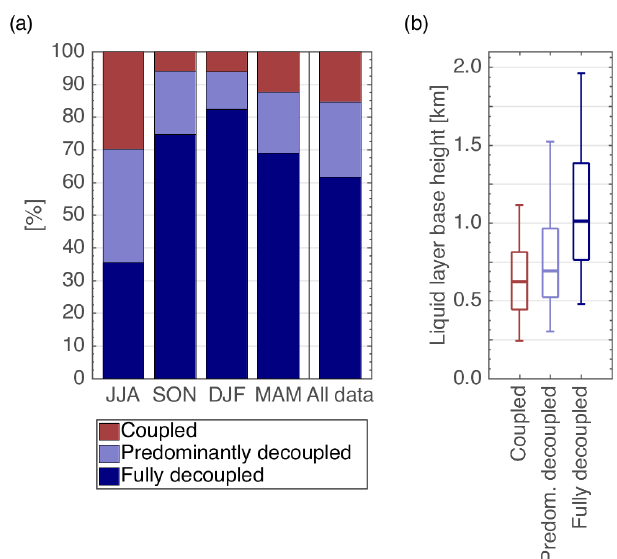
Figure 11. The fraction of P-MPC cases classified as coupled, pre- dominantly decoupled, and fully decoupled in each season and for the entire data set (a) , and the distribution of the liquid layer base height in the coupling classes (b) . Boxes and whiskers as in Fig. 7; the medians were found to differ on a 95% confident